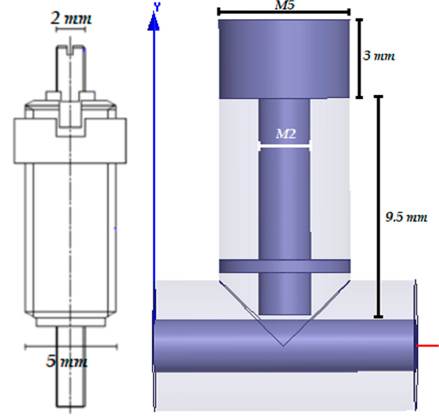
Figure 9. Size of the tuning screw in the substructure.